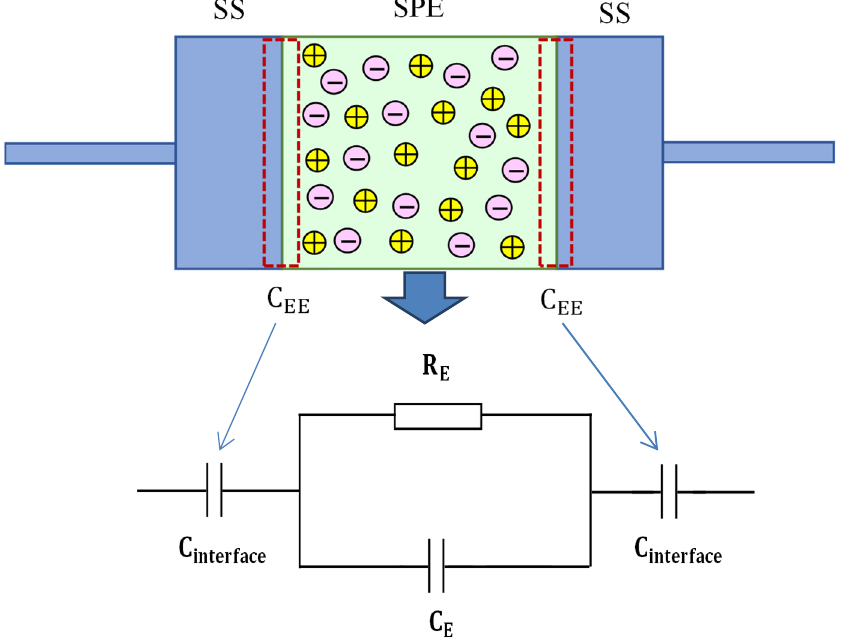
Figure 3. An EEC diagram for impedance graphs shows a high-frequency semicircle and a low- frequency tail as a schematic representation.